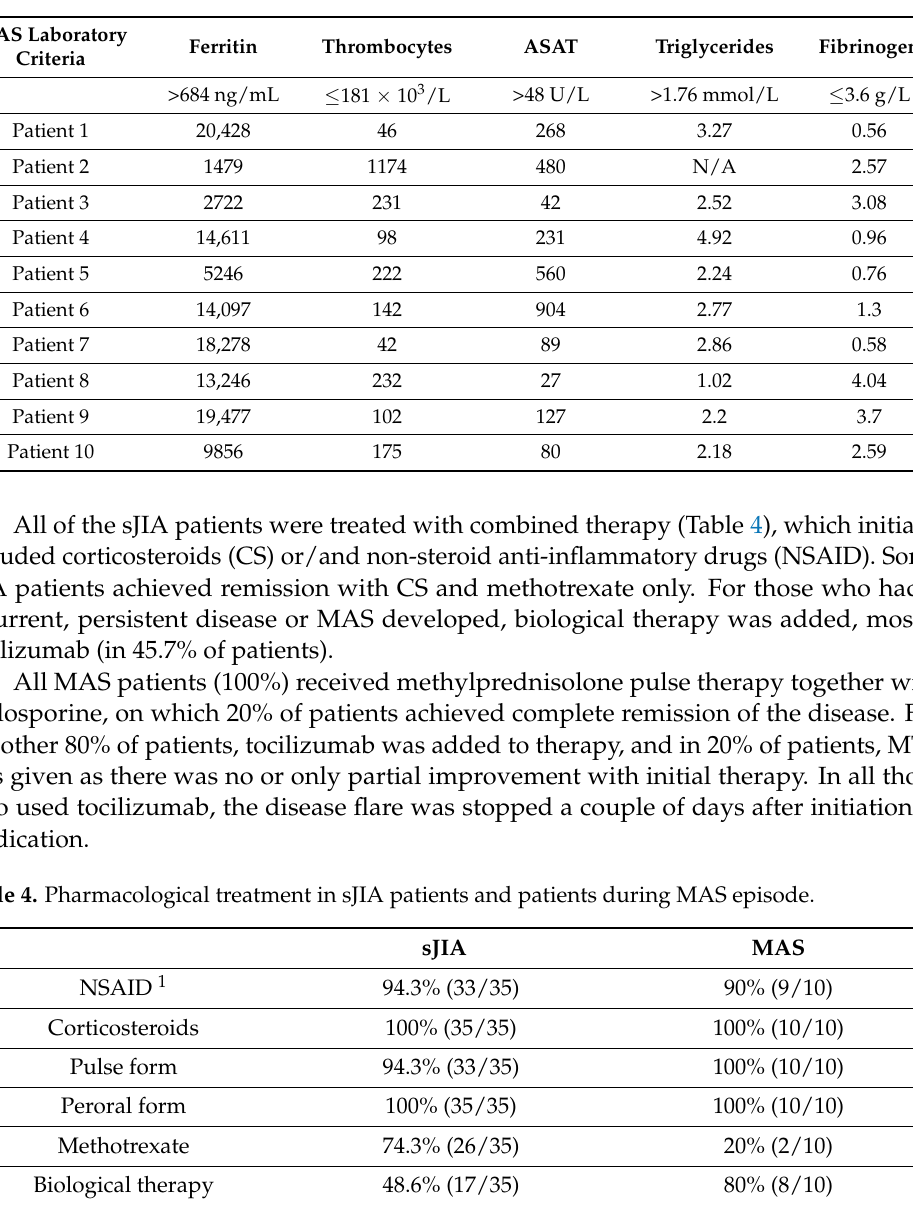
Table 3. Laboratory results in sJIA patients during MAS episode.